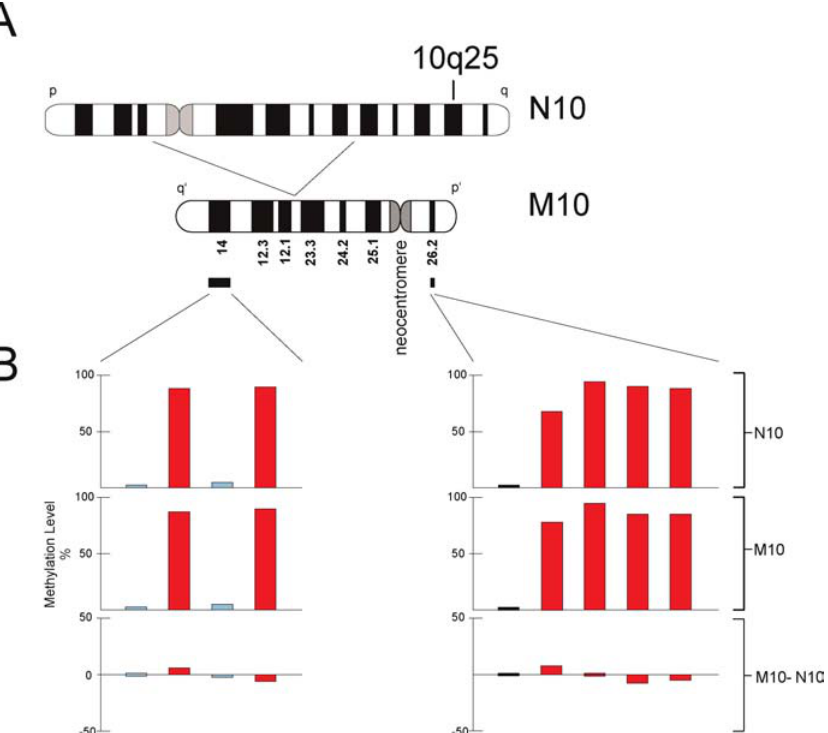
Figure 1. The 10q25 Locus and Control Regions Used in This Study (A) Chromosome ideogram representing the derivation of the M10 chromosome containing the neocentromere formed at the 10q25 band. CpG islands and CpG islets selected from the p14 and q26.2 bands situated 39 and 7 Mbp from the neocentric sites, respectively, were measured for methylation in both N10 and M10 cell lines. (B) The level of methylation is shown for the same CpG islands and CpG islets in N10 and M10, and for their differences (M10 minus N10). CpG islands of . 500 bp are represented by black bars; CpG islands of . 200 bp and , 500 bp are represented by light-blue bars; and CpG islets are represented by red bars. DOI: 10.1371/journal.pgen.0020017.g001